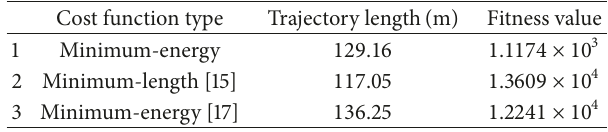
Table 4: Comparison results of trajectory length and fitness